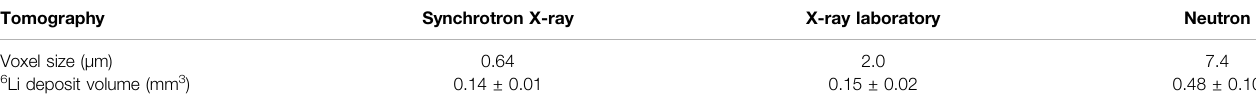
TABLE 1 | Comparison of the 6 Li deposit volume from the volume segmentation process depending on the tomography techniques and their voxel size. Tomography